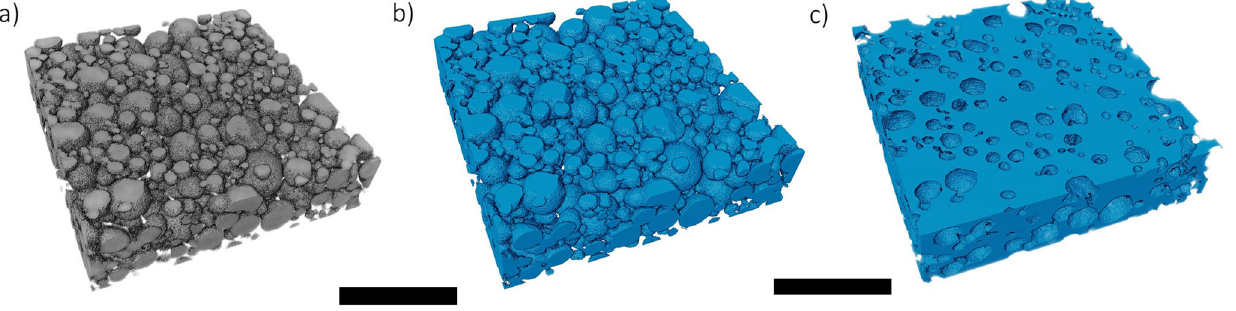
Fig. 2 Stages of image processing for GREAT. Stages of image processing, greyscale ( a ), segmented particles ( b ), and segmented pore and void space ( c ). The scale bar is 60 µm for each